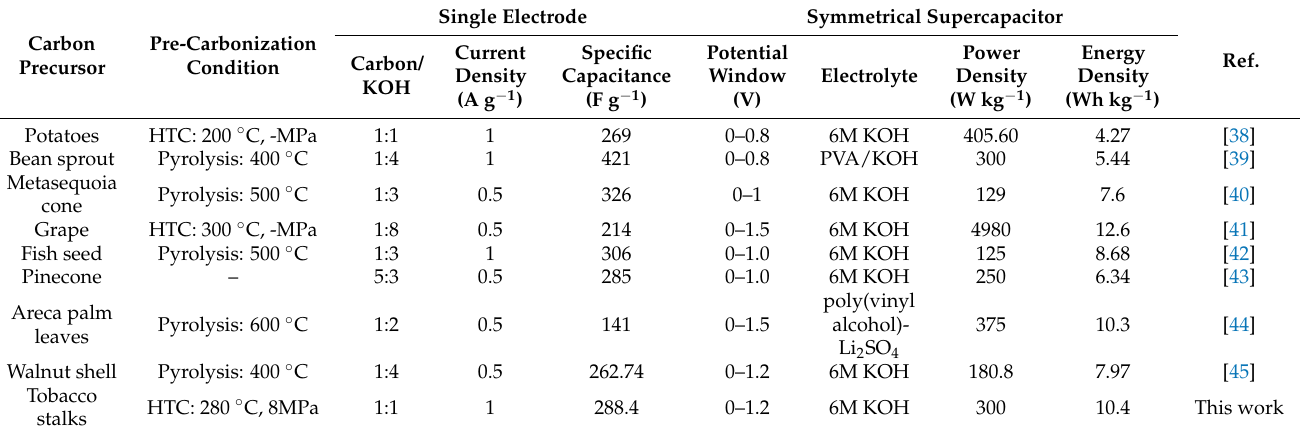
Table 3. Comparison of the electrochemical performance of biomass activated carbon reported in this study and other